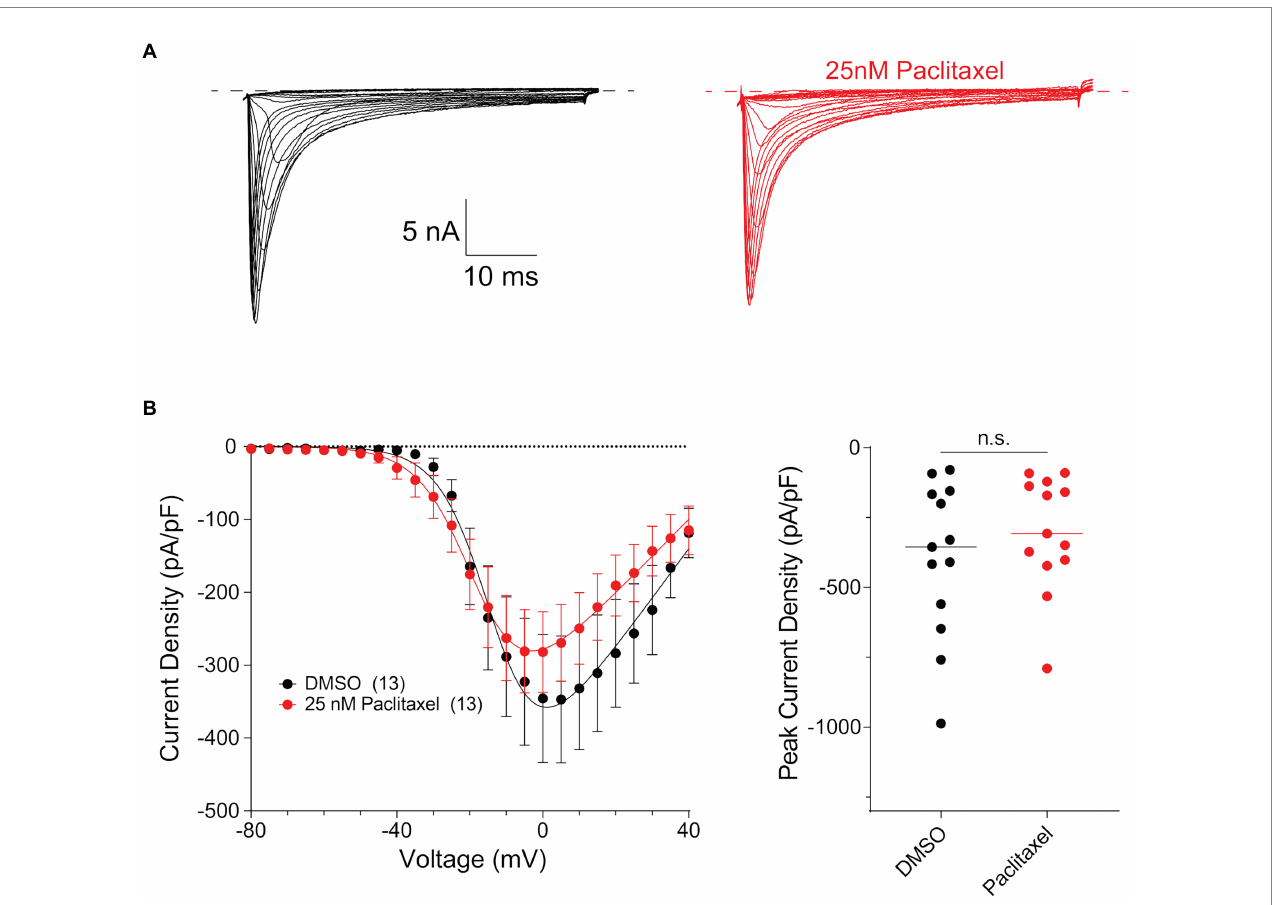
FIGURE 5 Paclitaxel does not affect density of current produced by endogenous Na V 1.8 in the somas of DRG neurons. (A) Representative family of somatic Na V 1.8 currents evoked by 100 ms depolarizing voltage steps from − 80 to − 40 in 10 mV increments from a holding potential of − 80 mV. Traces from rat DRG neurons treated with DMSO control (black) and 25 nM PTX (red) conditions are displayed. Traces are shown only for current evoked during the test-pulse and do not show the response from the pre-pulse stimulus. (B) Left panel shows current density-voltage relationships of currents produced by endogenous somatic Na V 1.8 channels in neonatal rat DRG neurons treated with DMSO (black; n = 13) or 25 nM PTX (red; n = 13). Data are presented as means ± SEM. Right panel shows distribution of peak current densities of cells. Means indicated by horizontal bars, no statistically significant differences were detected by Student’s t -test ( p >